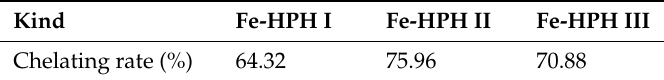
Table 3. The chelating rate of three kinds of Fe-HPH